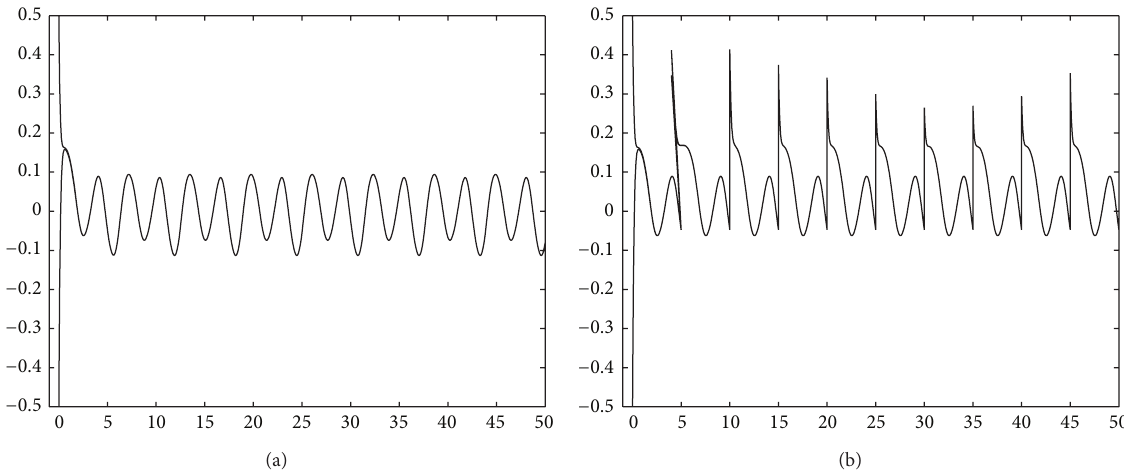
Figure 1: (a) Time response of state variables 𝑥 1 , 𝑢 1 without impulsive effects. (b) Time response of state variables 𝑥 1 , 𝑢 1 with impulsive effects.